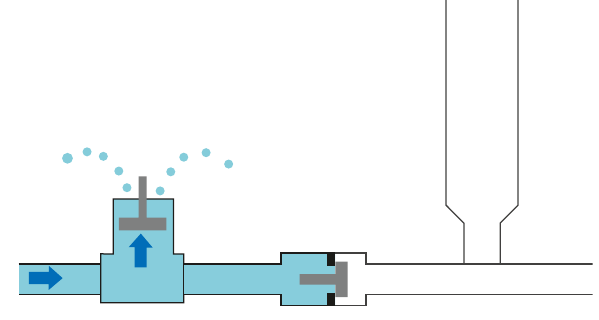
Figure 15: HRP working cycle: a wasting